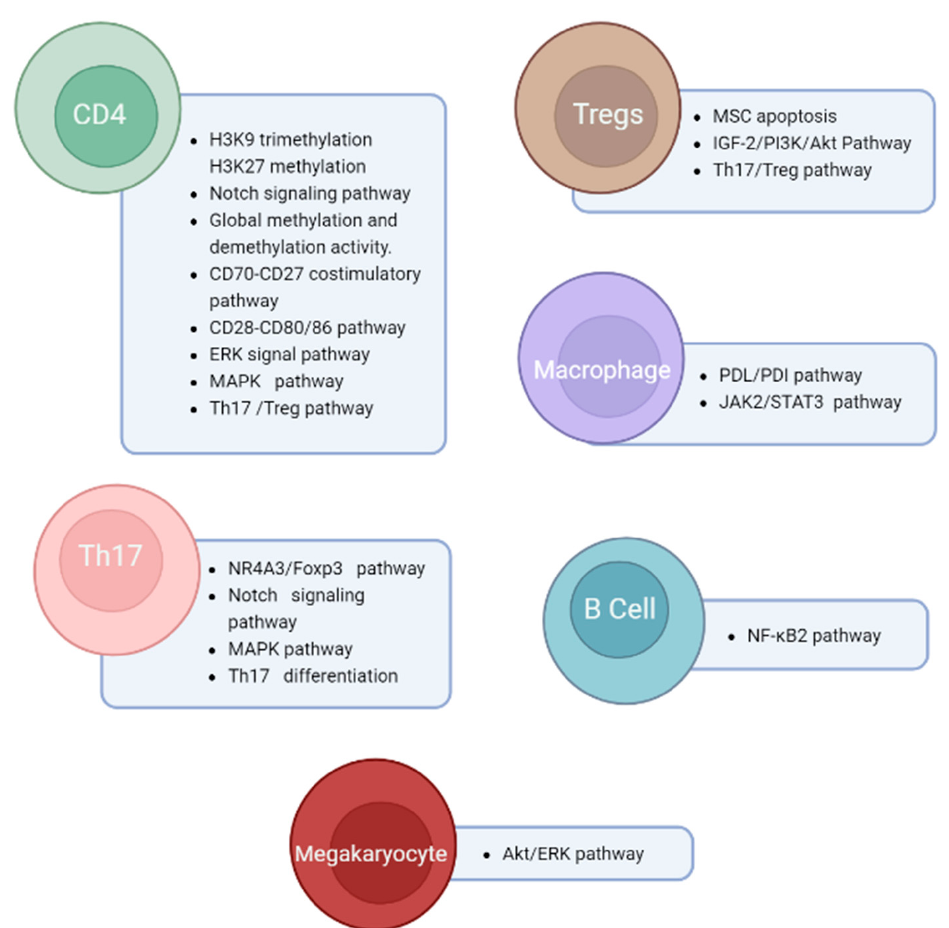
Figure 3. Pathways affected in ITP. Created with BioRender.com (accessed on 1 st February 2023)